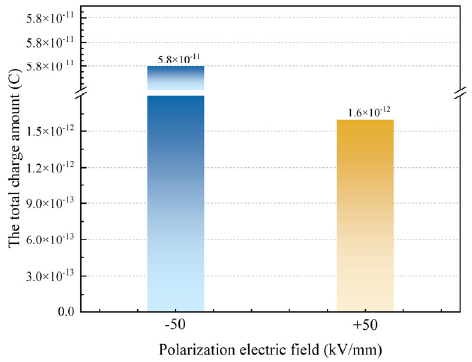
Figure 4. The total charge in PP under different polarization conditions.